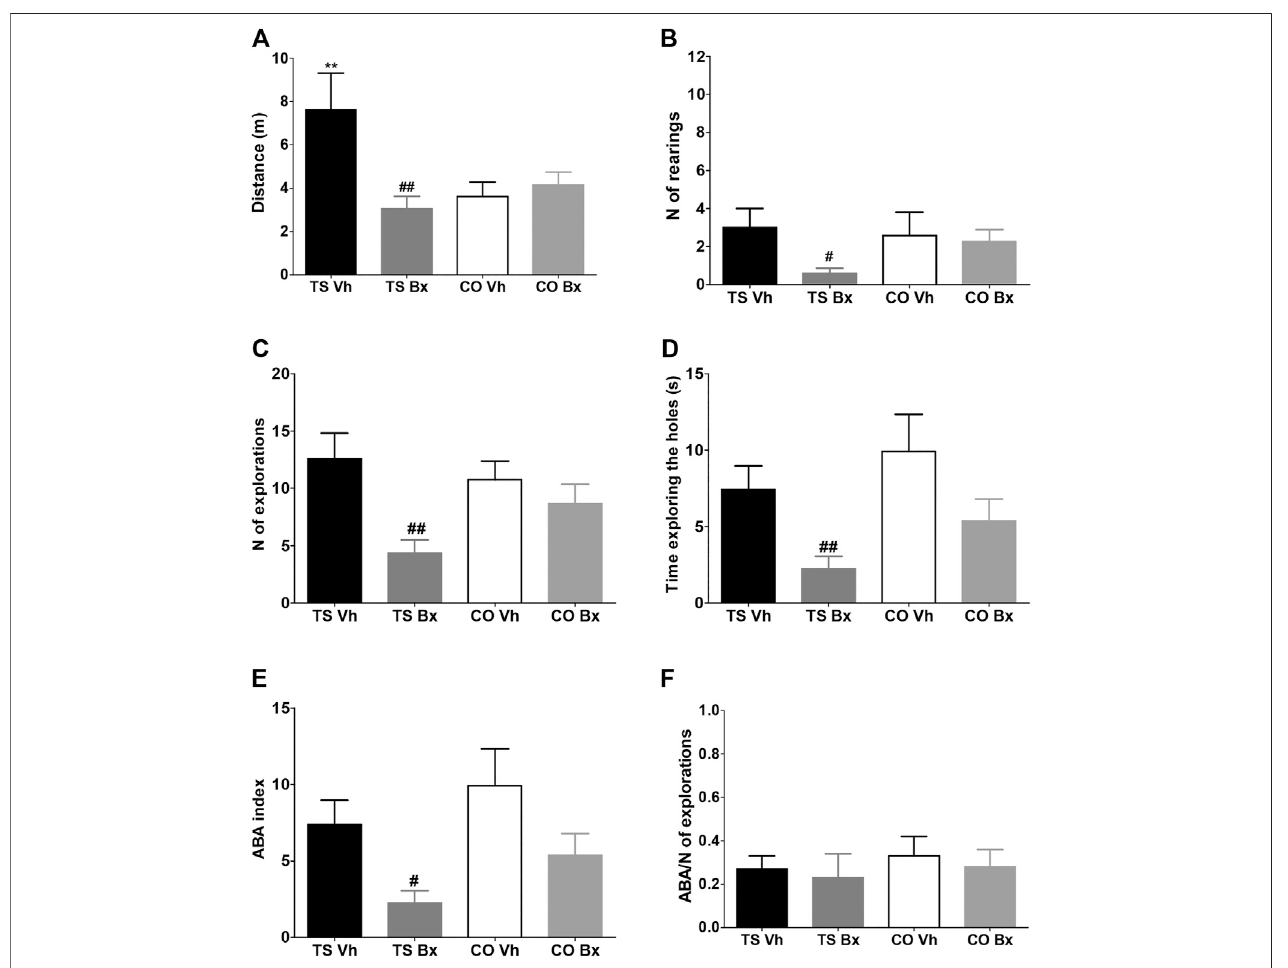
FIGURE 4 | Means ± S.E.M. of the distance traveled (A) , the number of rearings (B) , the number of explorations (C) , the time spent exploring the holes (D) , the number of repetitions of previously explored holes (ABA index, E), and the ratio of the number of repetitions of the exploration and the total number of explorations (ABA index/number of explorations (F) , performed by TSand CO mice under bexarotene or vehicletreatment in the hole board test. **: p < 0.01 TS Vh vs. CO Vh; #: p < 0.05, ##: p < 0.01 TS Bx vs. TS Vh. Fisher ’ s LSD post-hoc tests.